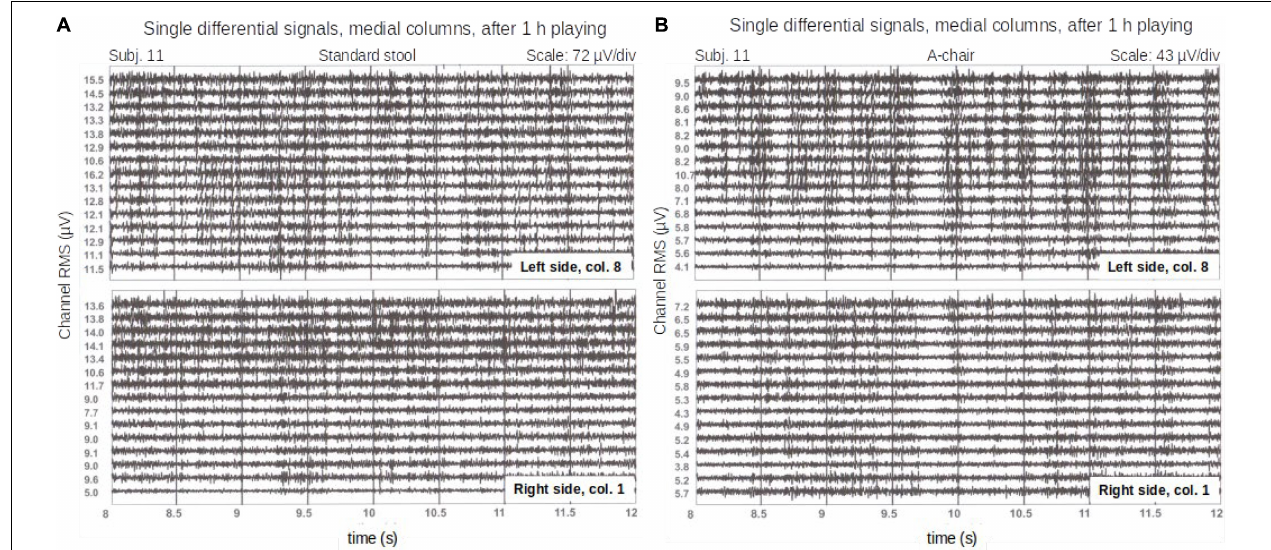
FIGURE 2 | Single differential signals from a pianist (column 8 of the left grid and column 1 of the right grid) on a time window of 4 s on the standard stool (A) and the A-Chair (B) . These signals were recorded after 55 min of continuous playing. The RMS values of each channel over the entire length of the signal (20 s), are reported next to each trace. Note the different scales on the signal